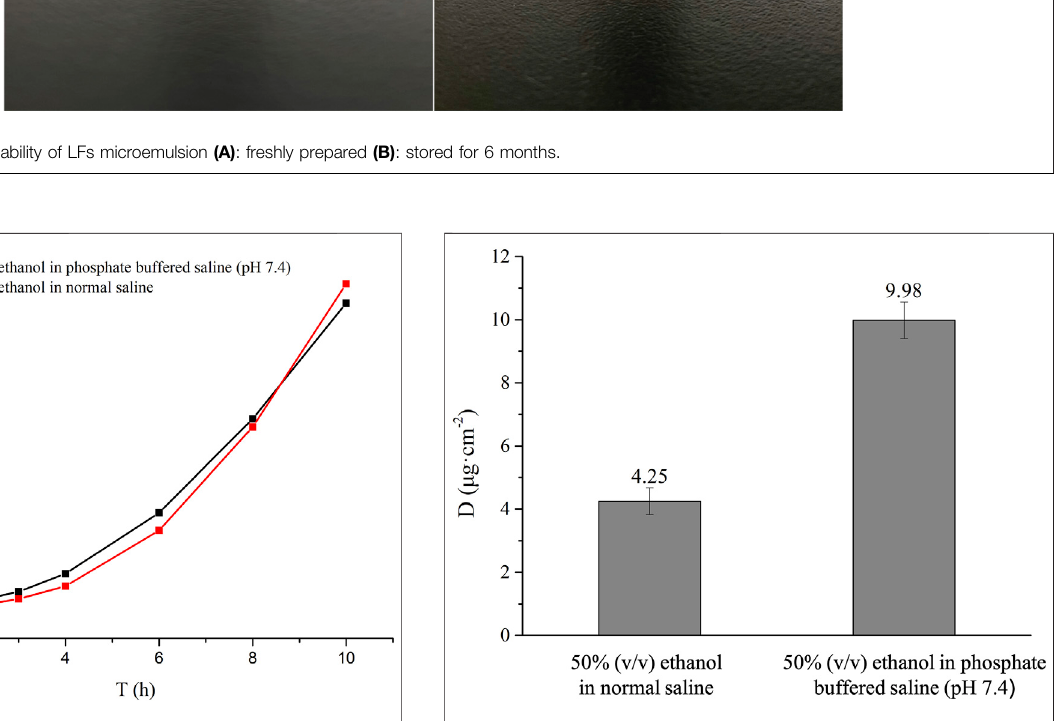
FIGURE 10 | The retention of LFs microemulsion in the skin of ICR mice after 10 h transdermal.